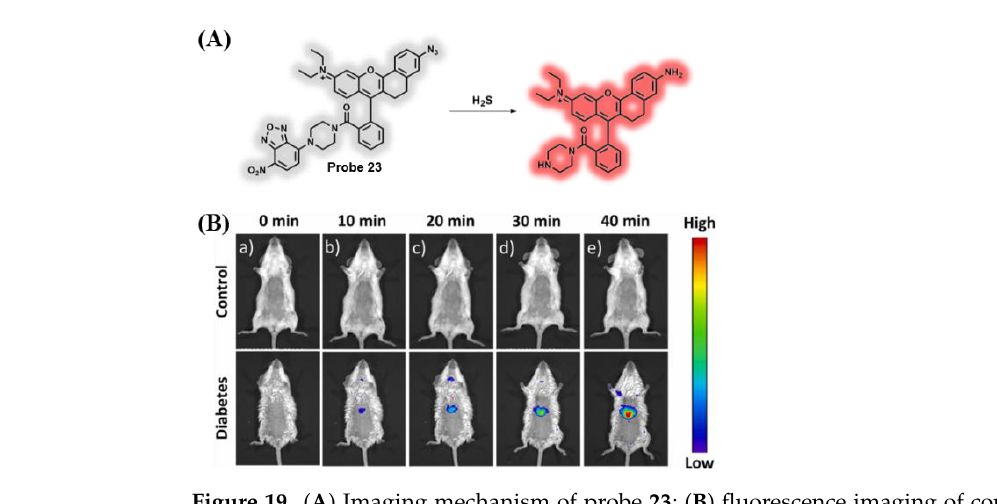
Figure 19. ( A ) Imaging mechanism of probe 23 ; ( B ) fluorescence imaging of control and diabetic mice. ( B - a ) 0 min; ( B - b ) 10 min; ( B - c ) 20 min; ( B - d ) 30 min; ( B - e ) 40 min. Adapted from Reference [103]. Copyright 2022 Elsevier B.V.